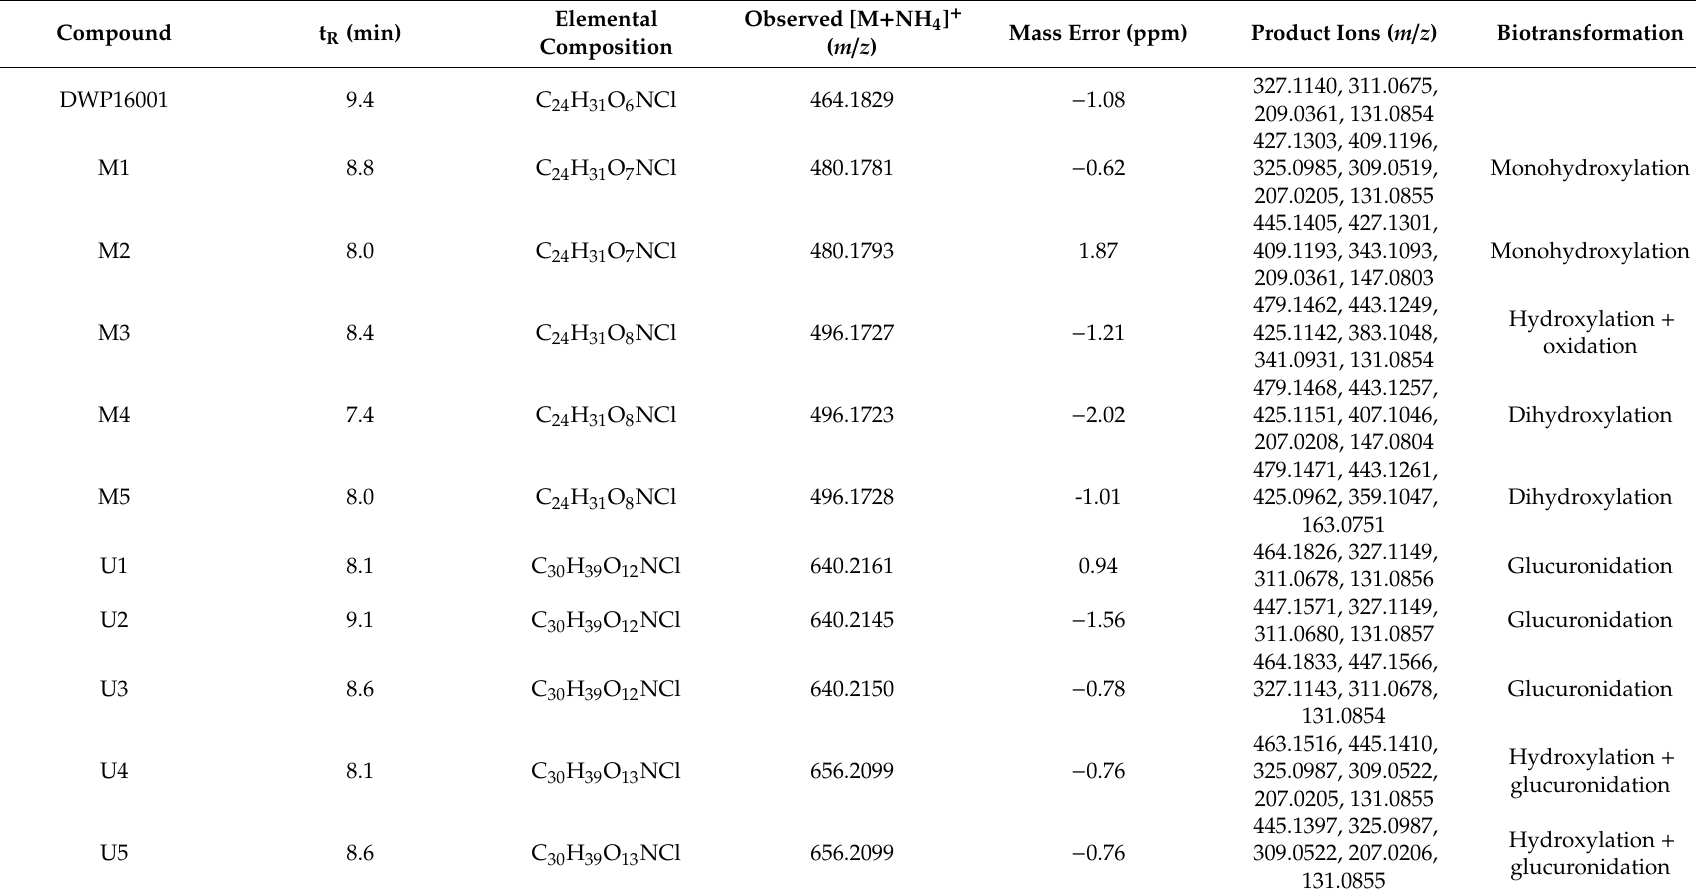
Table 2. Retention time (t R ), molecular formulae, observed molecular ions, mass errors, product ions, and biotransformation of DWP16001 and its metabolites identified in mouse, rat, dog, monkey, and human